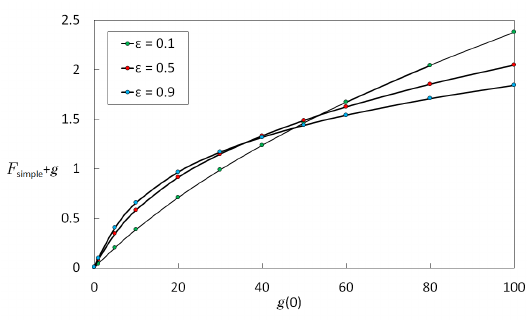
Figure 12. Dependence of the majorant F simple + g on the amplitude of the coupling constant g ( 0 ) for different values of the parameter ε . The width parameter w =